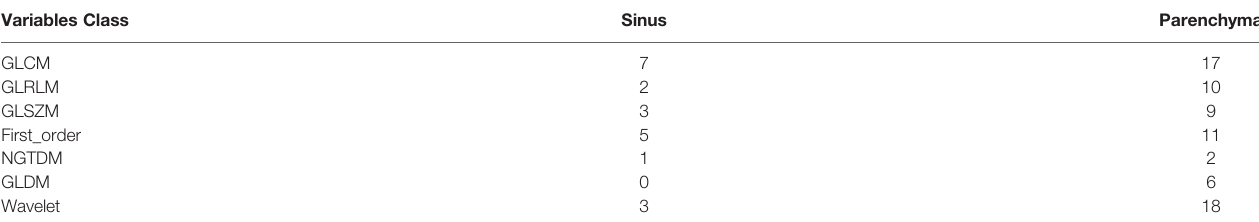
TABLE 3 | Class of Extracted variables.